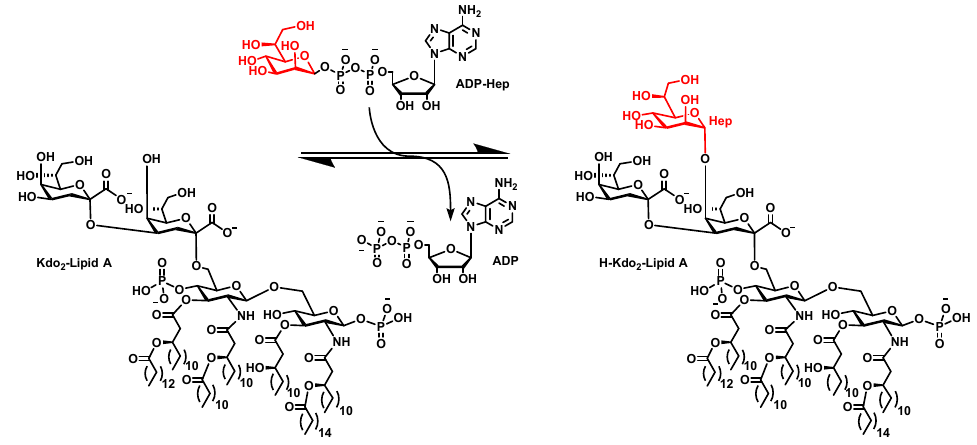
Figure 2. Reaction of HepI with ADPH and KLA showing the transfer of the heptose moiety (red). In addition to their described use with HepI, ADPH and KLA have a variety of other applications in biological and biochemical investigations. ADPH and KLA have both been shown to stimulate an immune response in vivo [13,14]. A 2018 study done by Pfannkuch et al. showed that organic extracts from H. pylori were abundant in ADPH, which was